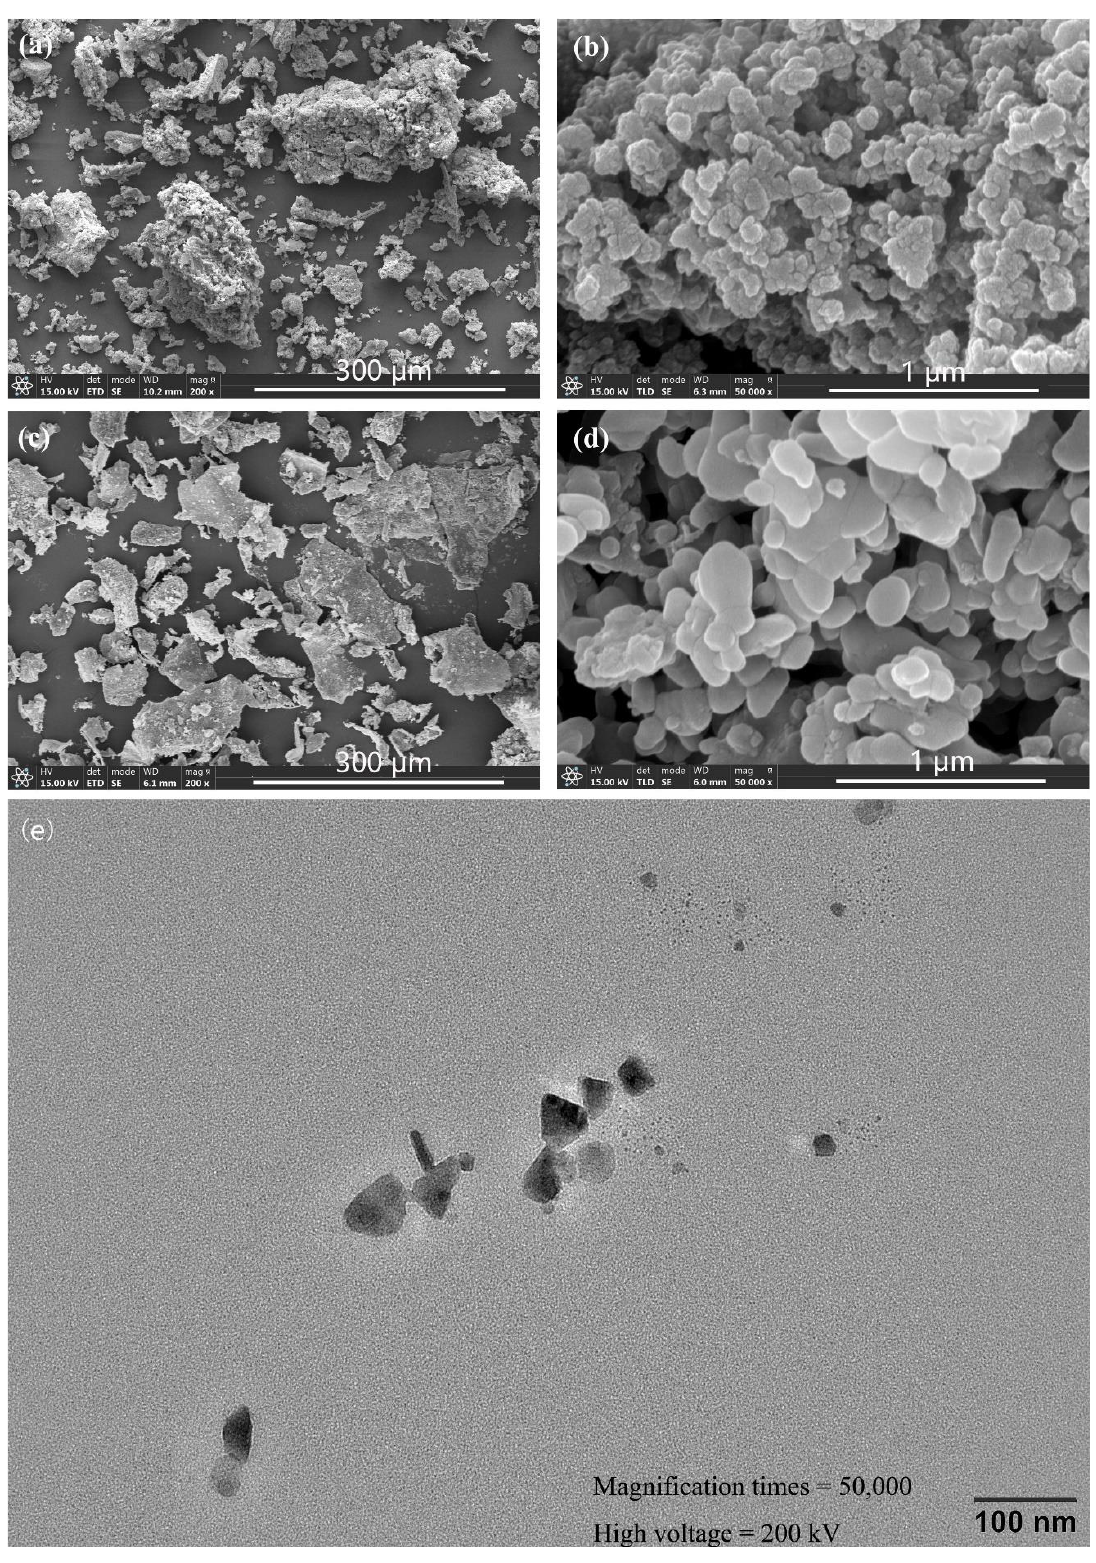
Figure 2. SEM images of FeS under 200 × ( a ), FeS under 50,000 × ( b ), CMC-FeS under 200 × ( c ), CMC-FeS under 50,000 × ( d ), and TEM images of CMC-FeS nanoparticles ( e ). SEM images elucidate microscopic morphology and size of the characterized particles. TEM images can be analyzed by a specialty image processing software named ImageJ to give the particle size distribution.